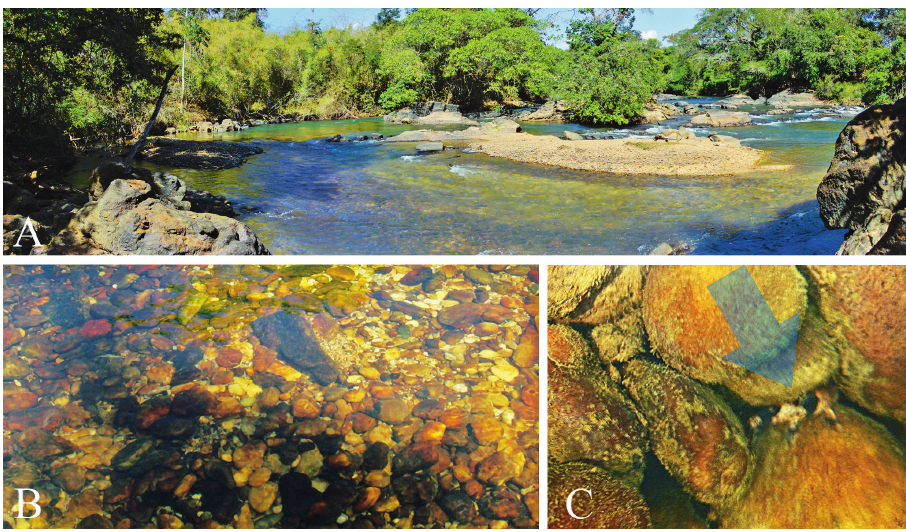
FIGURE 7 | A. Panoramic view of Rhyacoglanis varii type locality, rio do Peixe, Goianésia, state of Goiás, Brazil; B. Bottom with rocks, pebbles, and sand where specimens were collected; C. Blue arrow indicating water flow and pointing to a specimen beneath